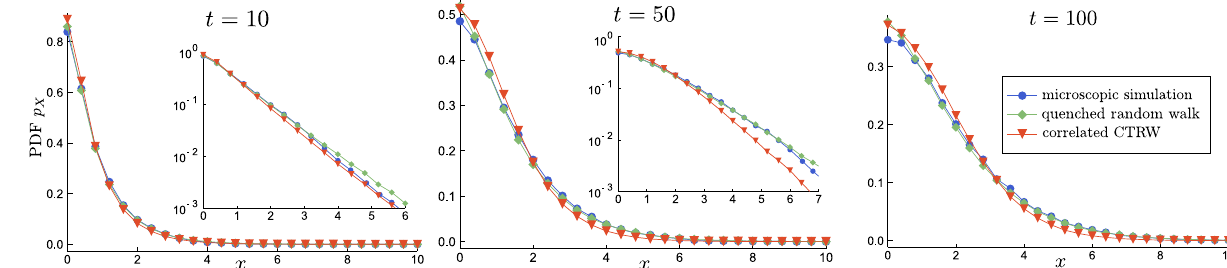
0.0005 ) of the diffusion process (6), (7) = 50 the majority of the PDF =